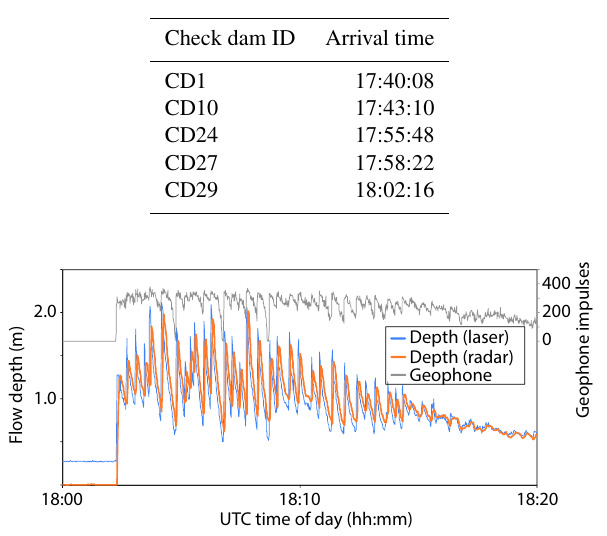
Table 1. Arrival times of debris-flow front at check dams instru- mented with geophones.